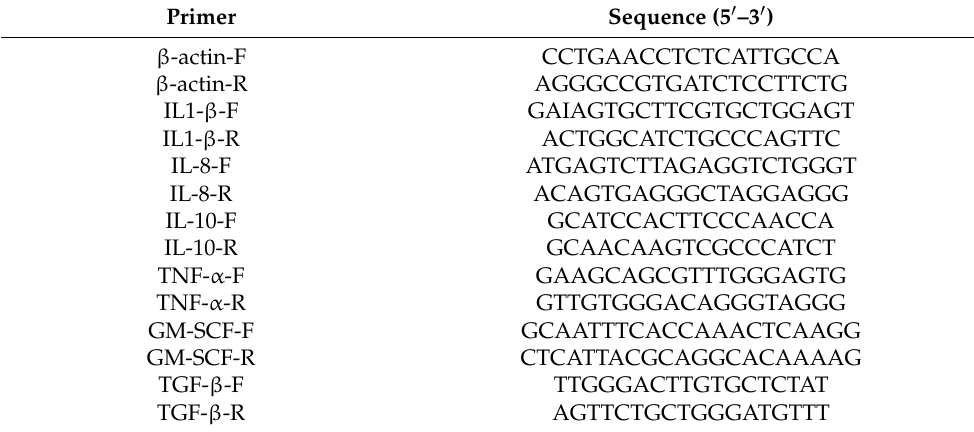
Table 2. Primers used for quantitative real-time PCR 1